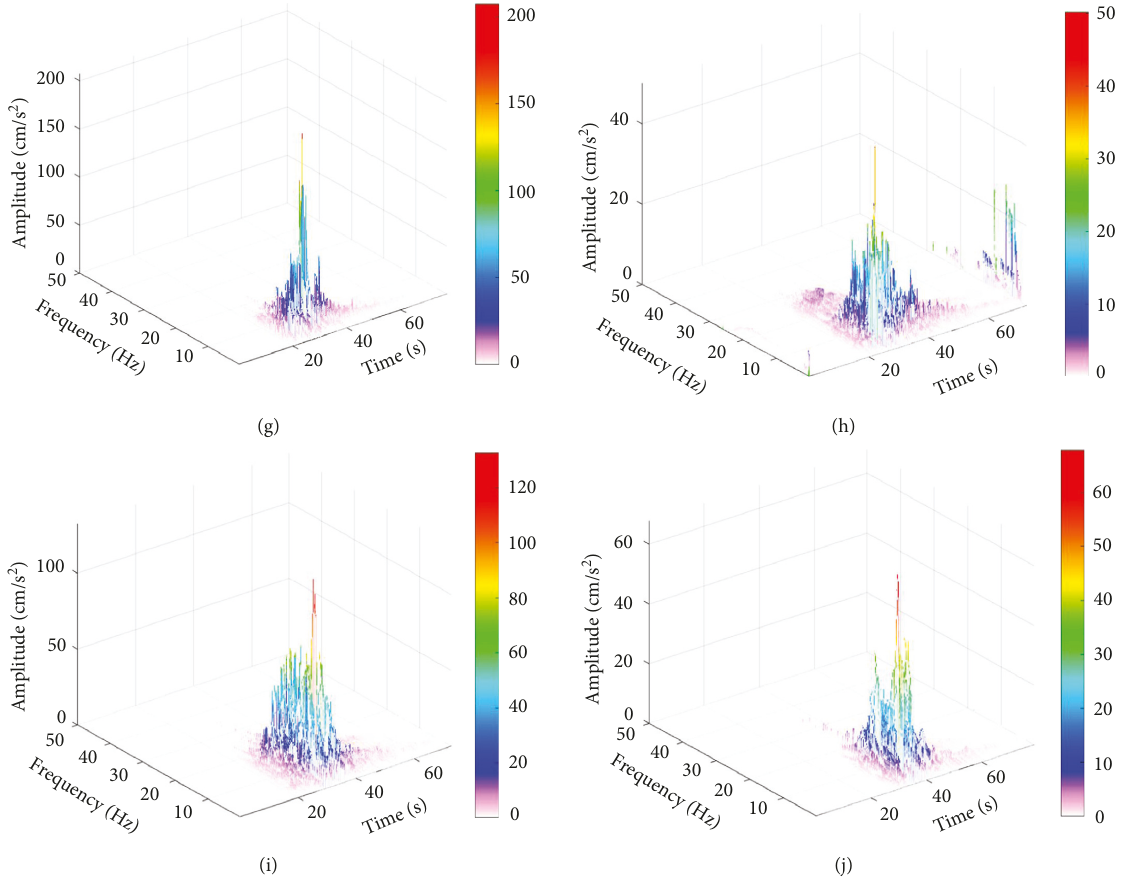
Figure 13: Hilbert spectrums of seismic wave in Yangbi earthquake and Ludian earthquake. (a) 53YBX. (b) L2203. (c) L2201. (d) L3003. (e) L2202. (f) 53LLT. (g) 53QQC. (h) 53LDC. (i) 53QJX. (j)